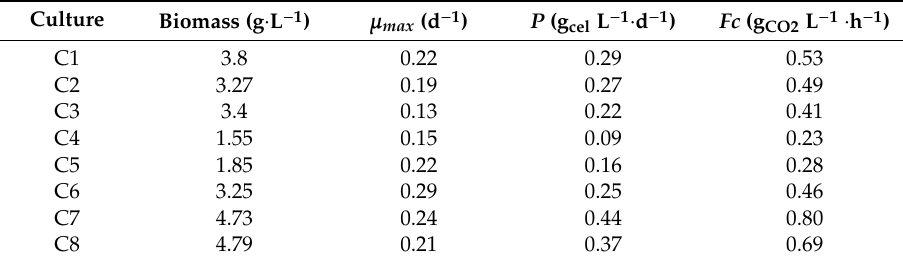
Table 4. Productivity P , CO 2 Fixation rate Fc and µ max of the